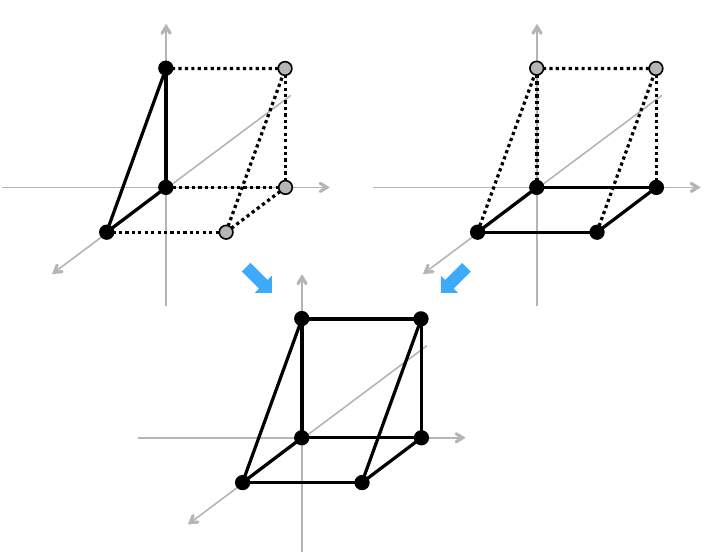
Figure 2. The D 3 toric diagram can be reached by lifting three points in C 3 or two points in the